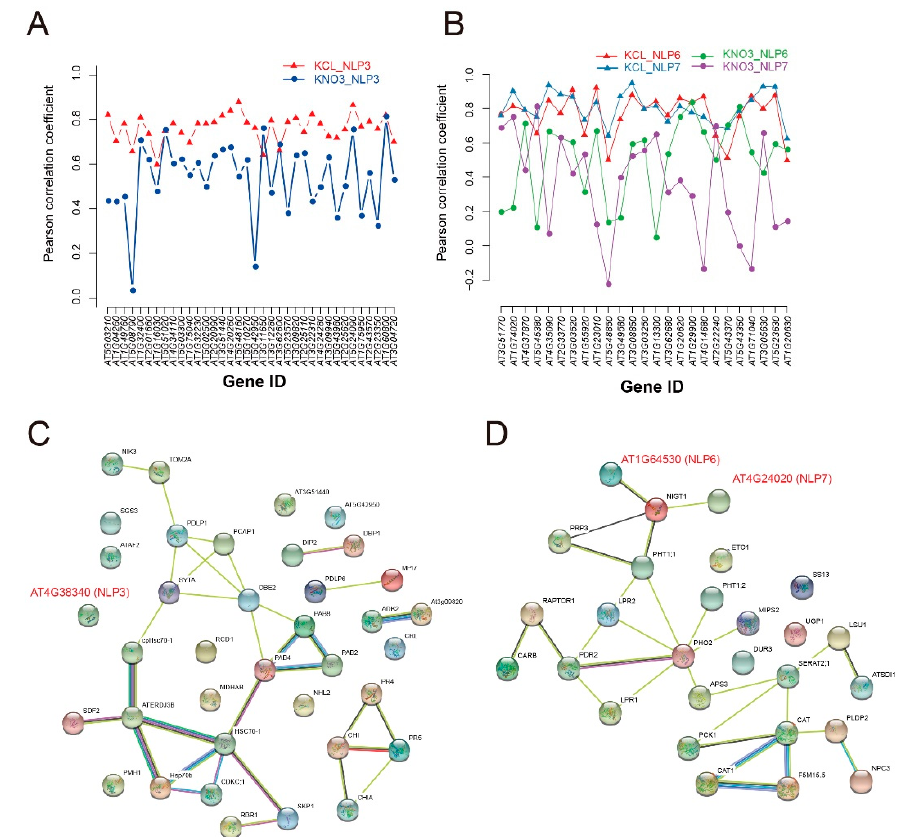
Figure 5. Relationships of AtNLP3 , AtNLP6 , and AtNLP7 to genes involved in symbiosis (GO:0044403) and starvation (GO:0009267) under N starvation. ( A ) Correlation of AtNLP 3 with genes from the enriched symbiosis-related GO term in the blue module. ( B ) Correlation of AtNLP6 and AtNLP 7 with genes from the symbiosis-related GO term in the green module. ( C ) Protein association network of AtNLP3 with proteins from the symbiosis-related GO:0044403 (symbiosis, encompassing mutualism through parasitism) constructed with STRING 11.0. ( D ) Protein association network of AtNLP6 and AtNLP7 with proteins from the symbiosis-related GO:0009267 (cell response to starvation) constructed with STRING 11.0.